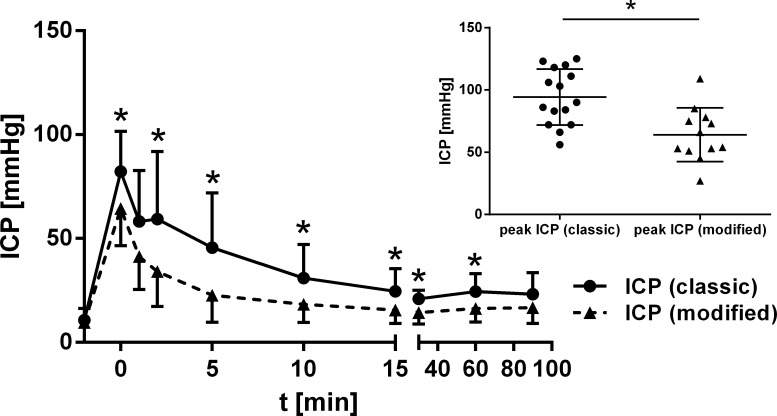
Chart for course of ICP.Course of ICP (mean +/- standard deviation) dependent on technique, * p<0.05, Boxplot of peak ICP (* p<0.05).